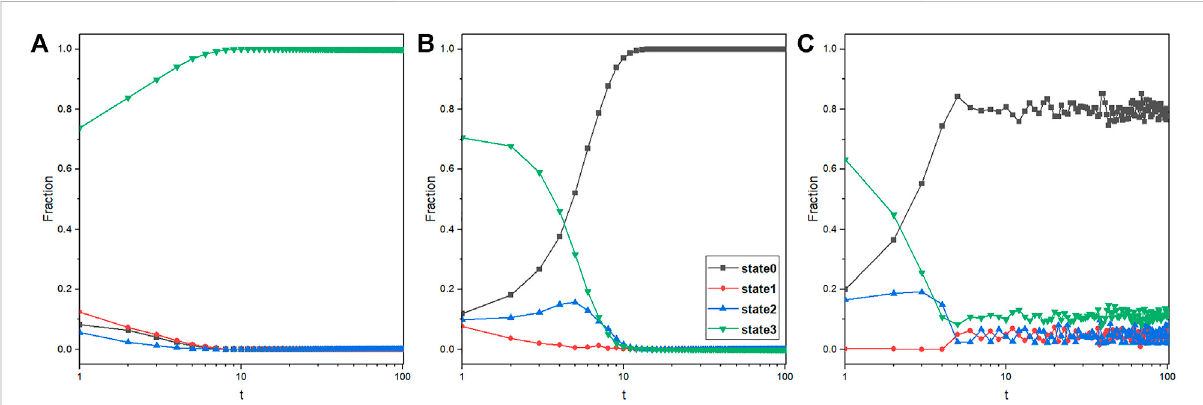
FIGURE 3 Fraction of individuals in different states as a function of time for α = 1 (A) , α = 0.6 (B) , and α = 0.2 (C) . Depicted results are obtained for γ = 0.8, K = 0.1, C V = 0.3,and C H =1. The state codes are as follows: state0 and state1 represent thevaccinated individuals inthe previous epidemic V 0 = 0.2, season that still vaccinate and do not vaccinate in the current season, respectively; state2 and state3 represent the non-vaccinated individuals in the previous epidemic season that vaccinate and still do not vaccinate in the current season,